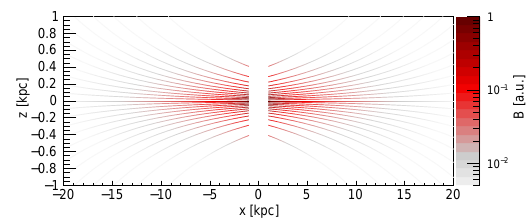
Figure 2. Side view of a exponentially flaring radial disk field ( h 0 = 0 . 13 kpc and r h = 9 . 22